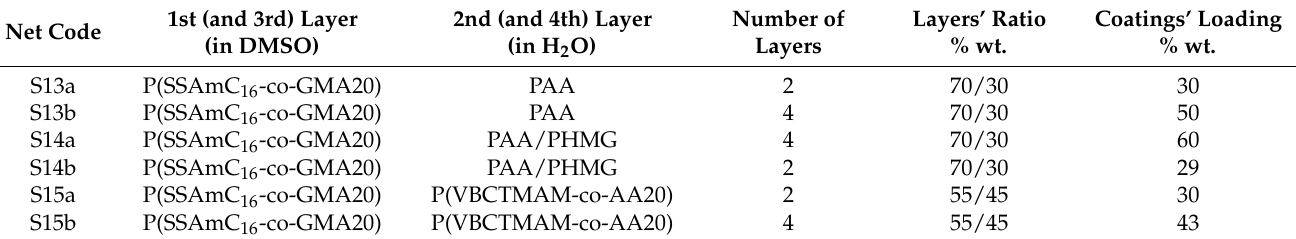
Table 4. Coating systems with different layers’ ratios and different percentages of total coating.